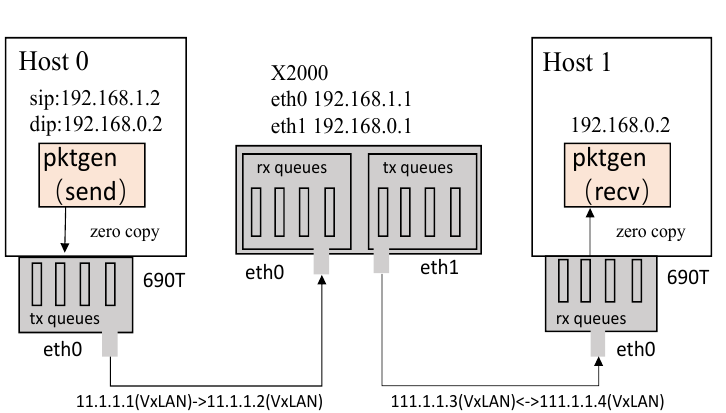
Figure 6. Experiment